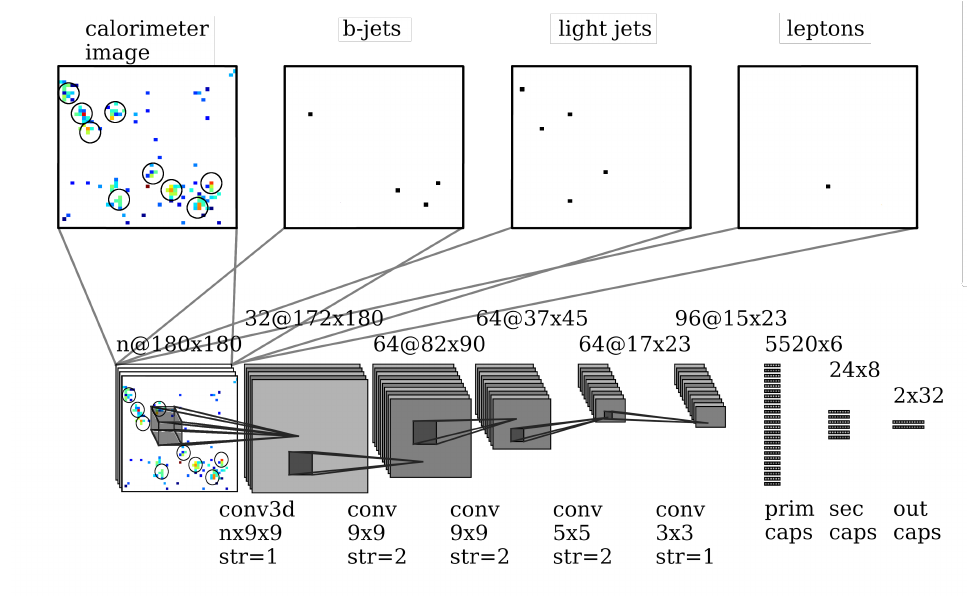
Figure 14: t ¯ tH CapsNet 3D convolution architecture with additional jet flavor and lepton